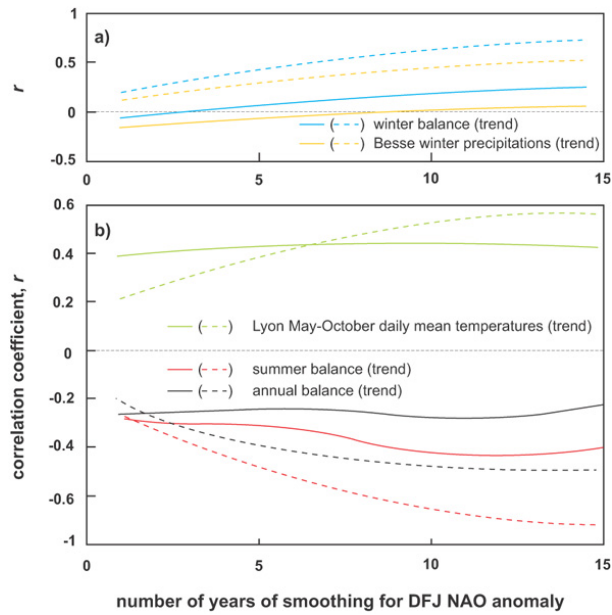
Fig. 5. Correlation between NAO winter (DFJ) anomalies and lo- cal variables as a function of the level of smoothing. (a) Winter variables: winter mass balance and Besse winter precipitations; (b) summer/annual variables: summer and annual mass balances, and Lyon-Bron May to October mean temperatures. Continuous and dashed lines refer to annual and trends of local variables, respec- tively.